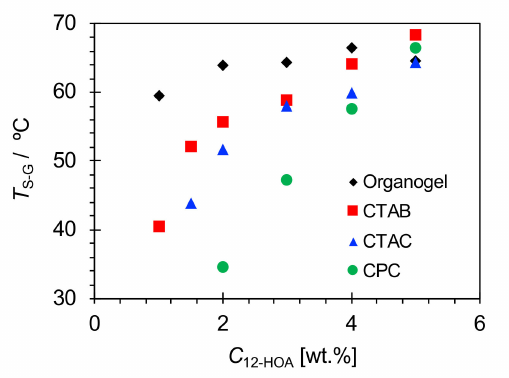
Figure 4. Sol-gel transition temperatures ( T S-G ) for the hydrogels and